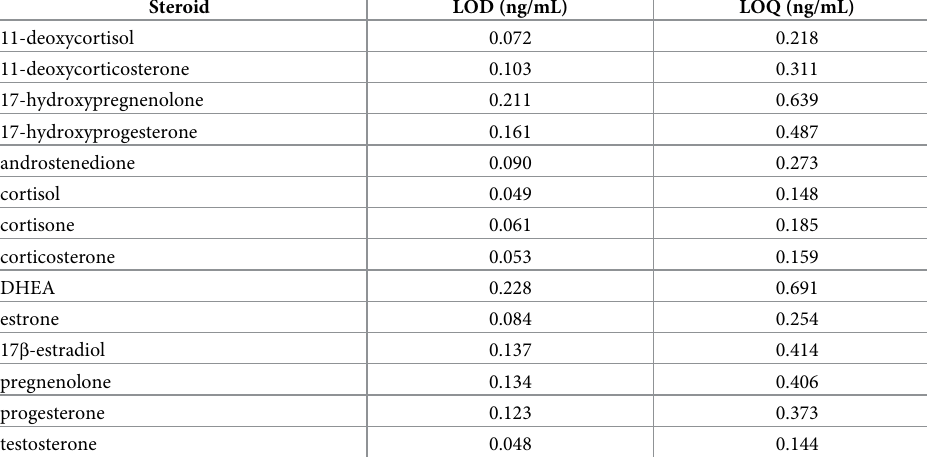
Table 1. Limits of detection (LOD) and limits of quantification (LOQ) for individual steroid hormones using